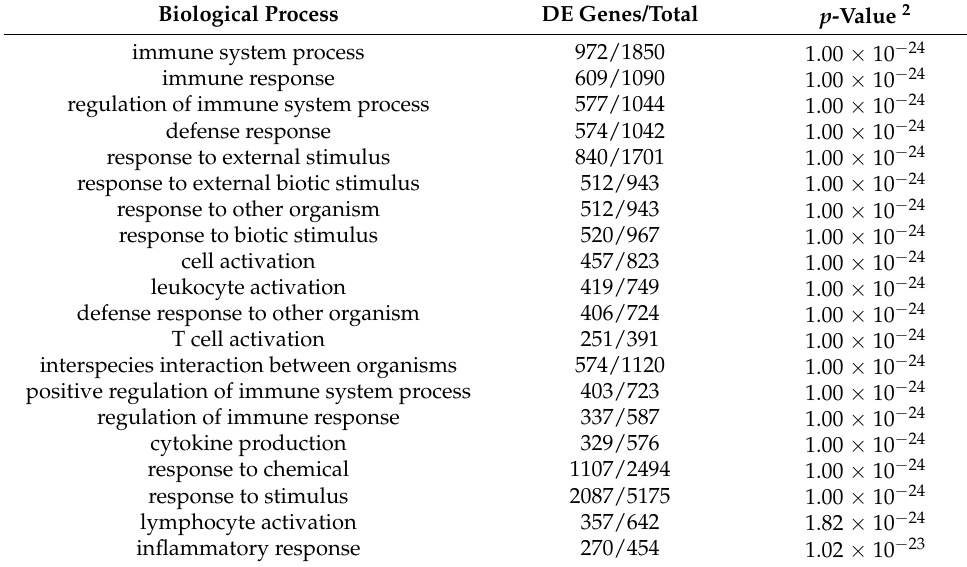
Table 2. Top 20 biological processes enriched in WT lacrimal glands 1 .